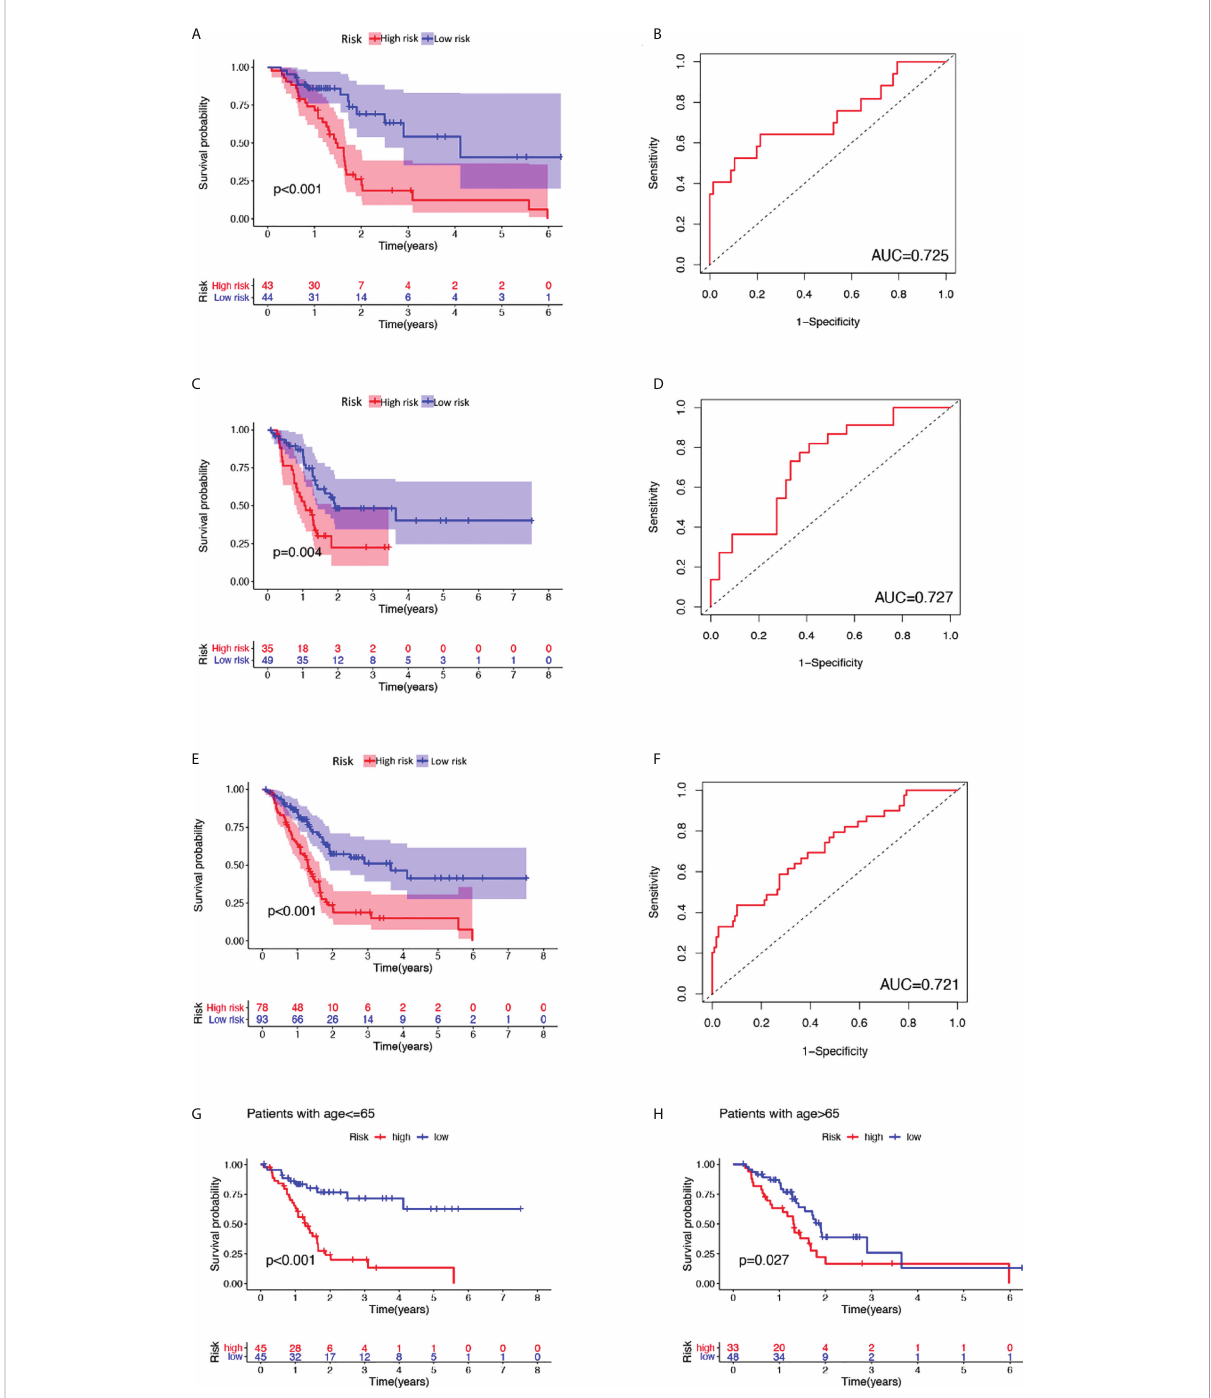
FIGURE 2 Outcome prediction of constructed GILncSig and veri fi cation as a valid prognostic factor independent of key clinical features. (A) , (C) , (E) Kaplan-Meier estimates of overall survival predicted by GILncSig for low-risk or high-risk patients in the training set, testing set and the combined TCGA cohort, respectively. Statistical analysis was performed using the log-rank test. (B) , (D) , (F) Time-dependent ROC curve analysis of GILncSig at 3 years in the training set, testing set and the combined TCGA cohort. (G) Kaplan-Meier estimates of overall survival predicted by GILncSig for low-risk or high-risk patients in young-patient group (age ≤ 65). (H) Kaplan-Meier estimates of overall survival predicted by GILncSig for low-risk or high-risk patients in old-patient